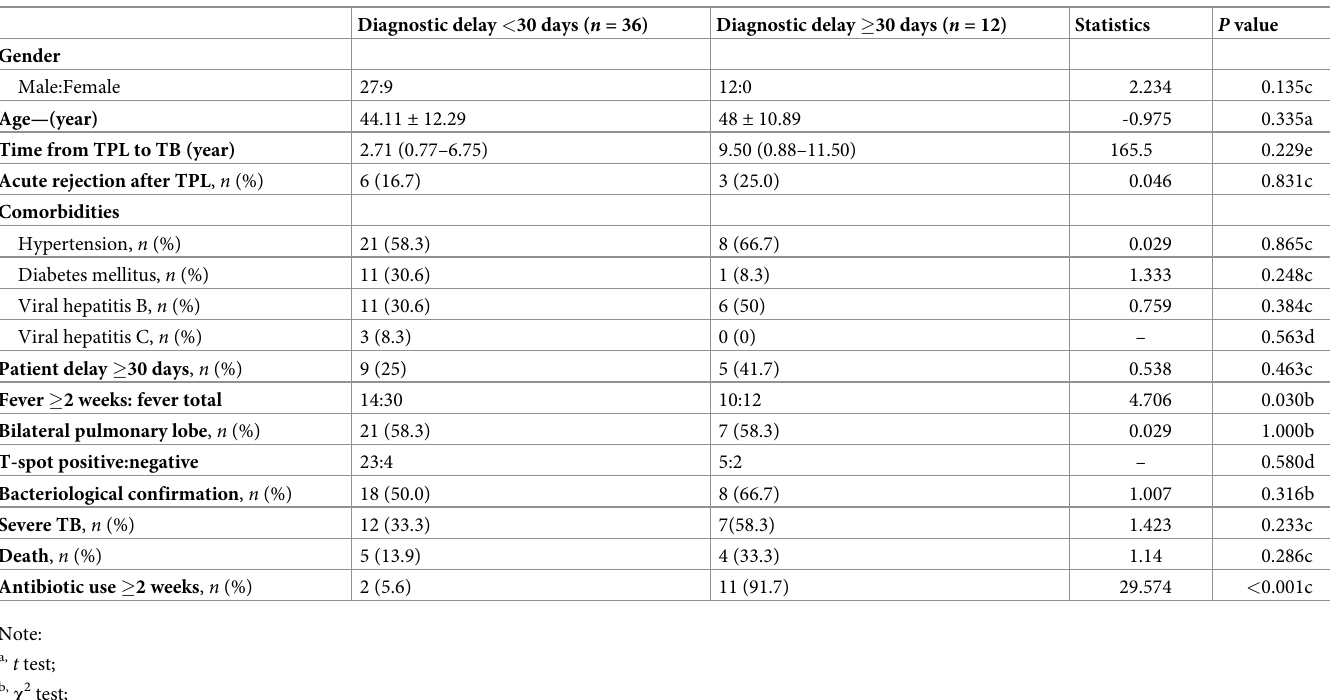
Table 3. Related factors for diagnostic delay ( (cid:21) 30